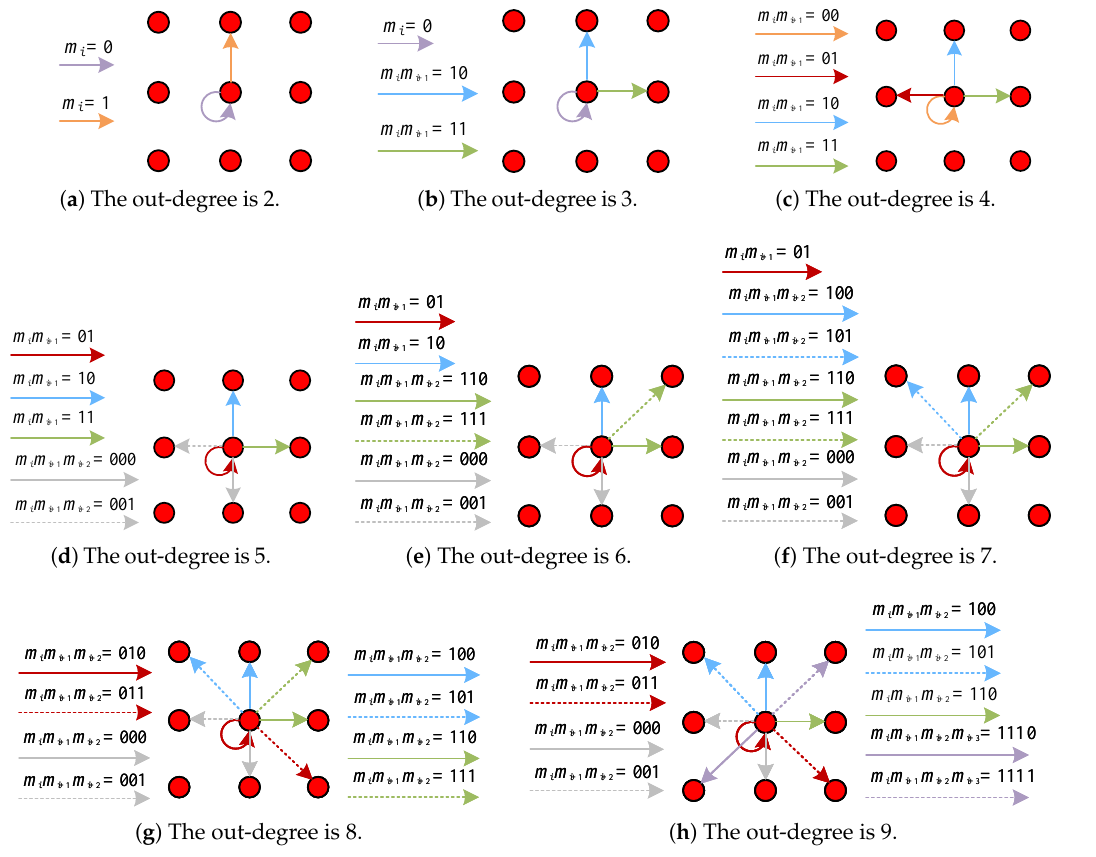
Figure 3. The best embedding modes for a given